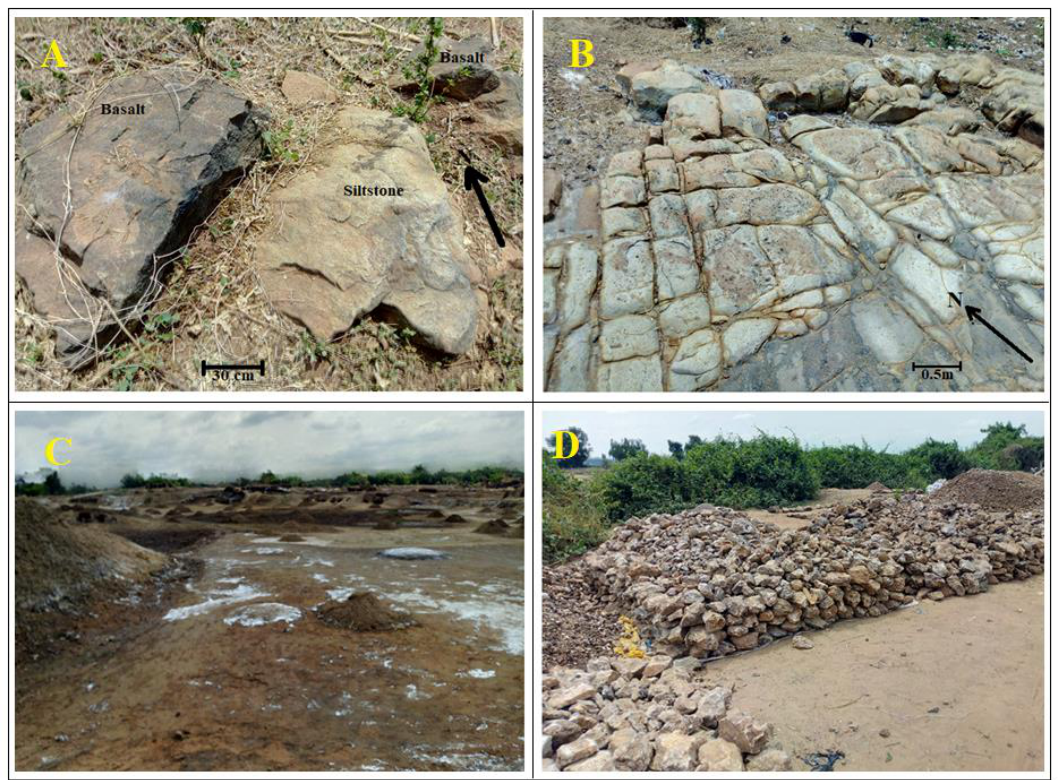
Figure 12. Structures and mineralization around the Akiri and Awe hot springs in the Middle Benue Trough. ( A ) Tertiary basalt intruding the Cretaceous sandstone of the Awe Formation. ( B ) Intense faulting and fracturing at the vicinity of the Awe hot spring due to heavy tectonic activities around the area, resulting in lineaments predominantly trending in NE–SW and NW–SE directions. ( C ) Salt (NaCl) mineralization around the Akiri hot spring. ( D ) Barite (BaSO 4 ) mining at the MBT. Barium sulfate is formed in veins and fractures as a result of hydrothermal crystallization.